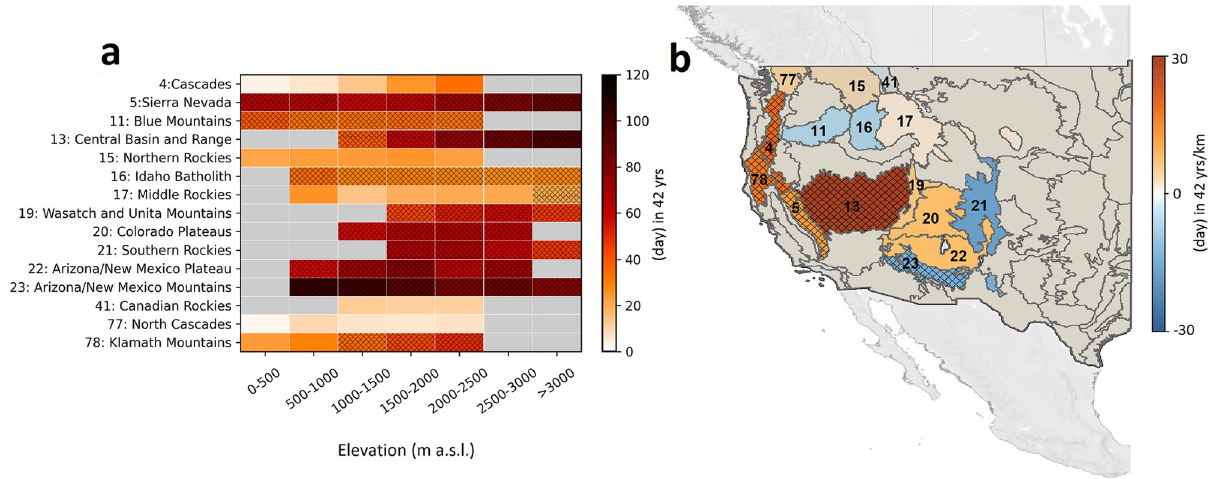
Fig. 4 | Elevation-dependent increase in critical fi re danger days. a Temporal trends in critical fi re danger days from 1979 to 2020 in each elevation band and ecoregion. b Slope of temporal trends in critical fi re danger days across elevation bands. (© OpenStreetMap contributors 2017. Distributed under the Open